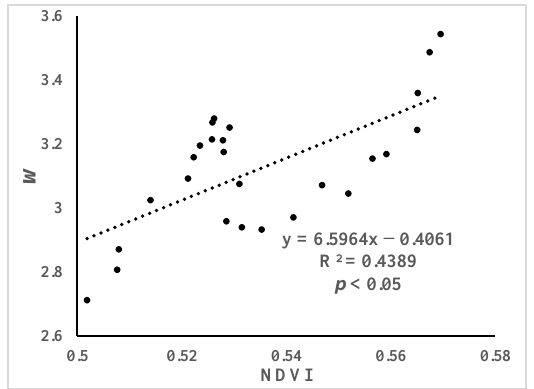
Figure 5. The relationship between the 10-year running average w and NDVI values.